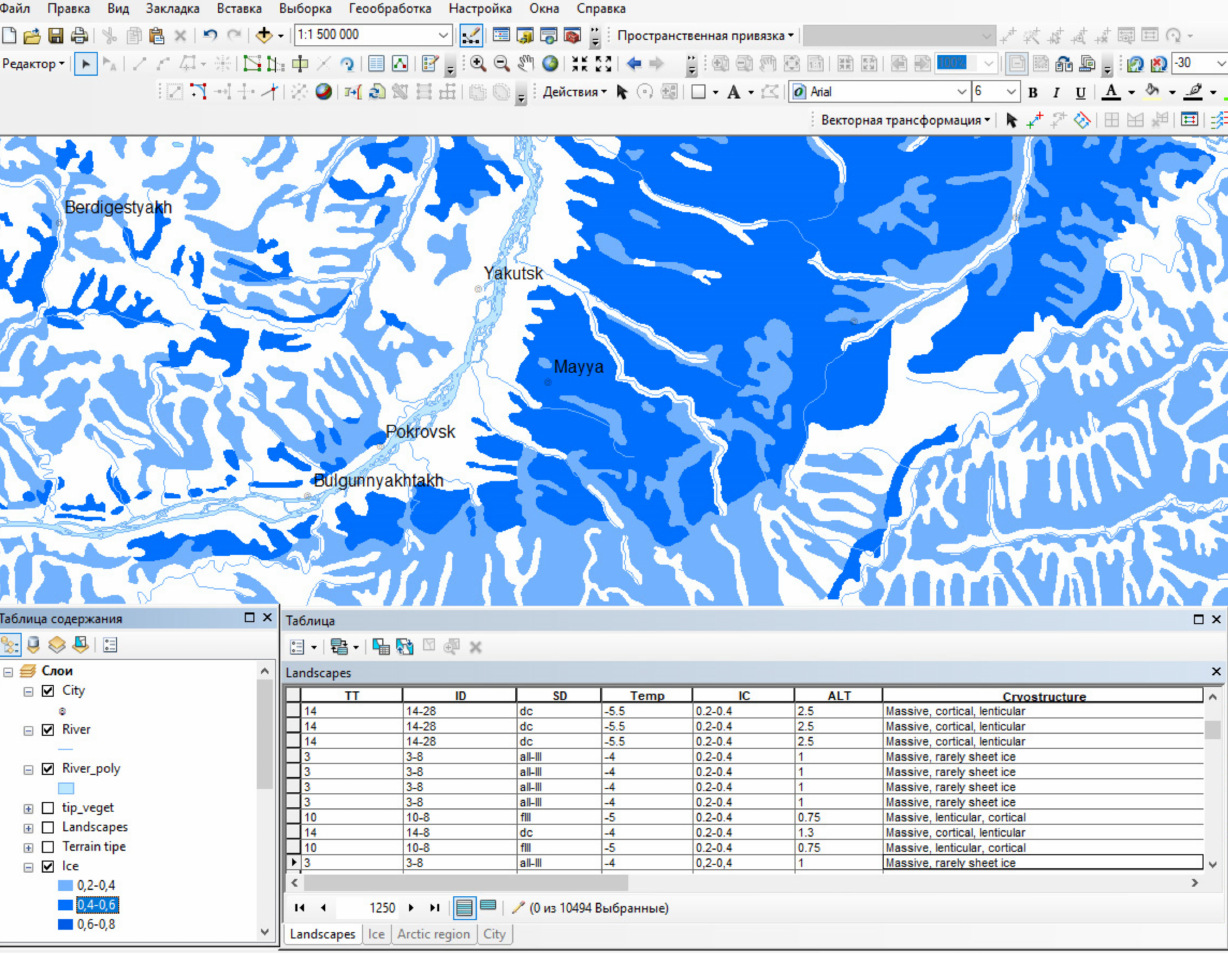
Figure 2. Fragment of attribute table and its map representation in the ArcGIS environment. Symbols in attribute table: TT—terrain types, ID—combination of terrain type and vegetation group, SD—types of surficial deposits; Temp—ground temperature, IC—ice content, ALT—active layer thickness, Cryostructure—cryogenic structure of surficial